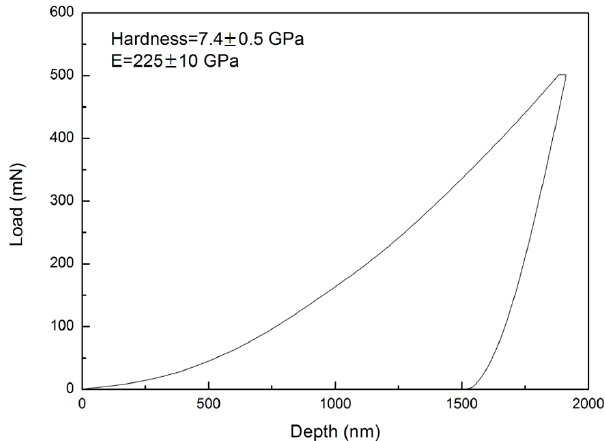
Figure 3. Load-depth indentation curve belonging to the surface of the cold sprayed IN625 coating.